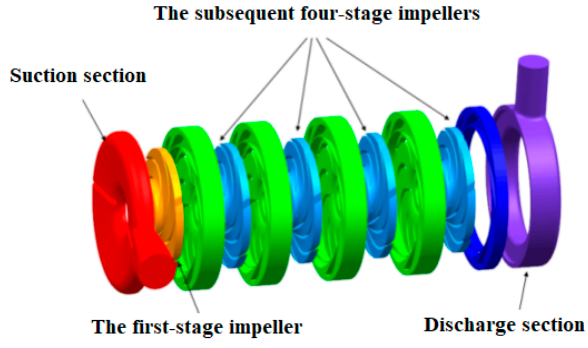
Figure 3. Simulation domain.